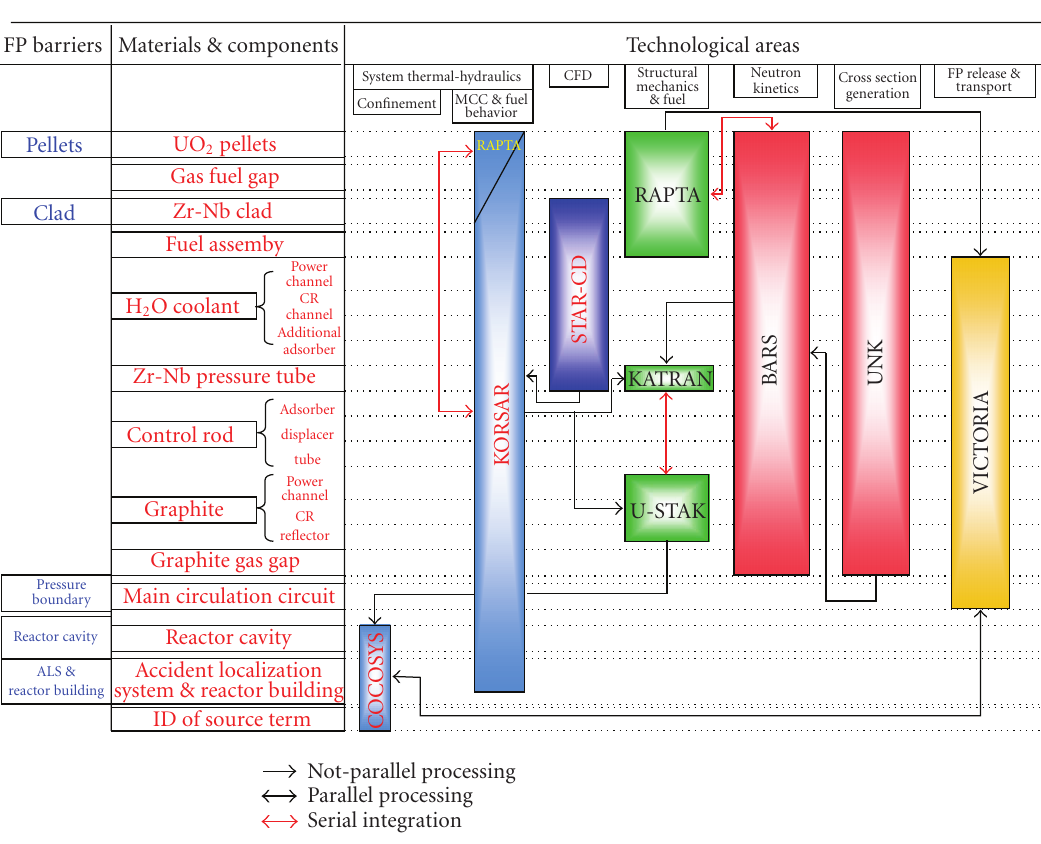
Figure 1: Connection between topological subjects in nuclear technology and codes adopted for the conduct of the project by NIKIET.